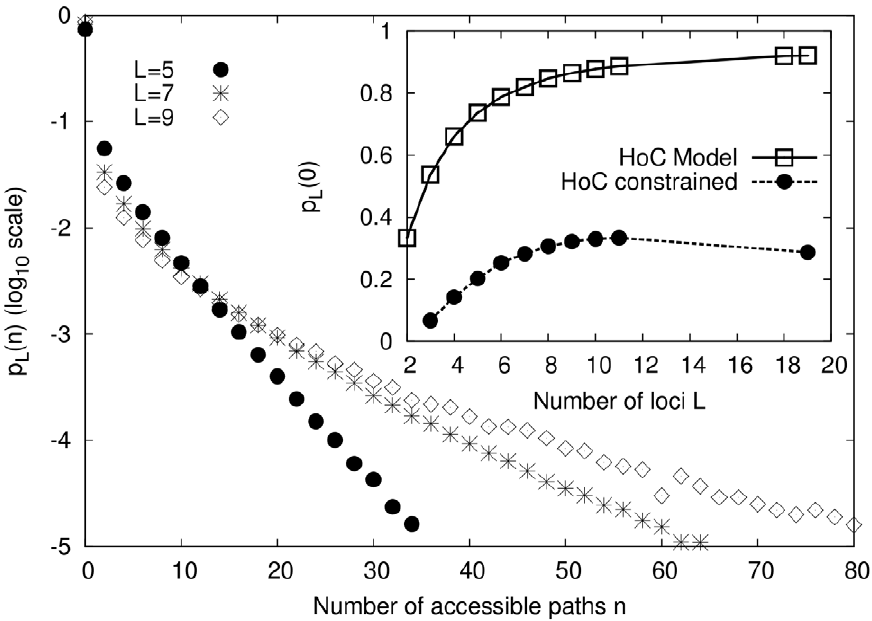
Figure 2. Accessibility of mutational pathways in the House-of-Cards model. Main figure shows the distribution of the number of accessible paths for three different sequence lengths in the HoC model in semi-logarithmic scales. The value of p L (0) is an outlier, indicating that a large fraction of landscapes have no accessible paths at all. This is a typical feature of rugged fitness landscapes of moderate dimensionality L , see Figures S4 and S5. Inset shows p L (0) as function of L for the HoC model. The top curve makes no assumptions about the antipodal sequence, while the bottom curve assumes it to be the global fitness minimum. Note the decline in the bottom curve.